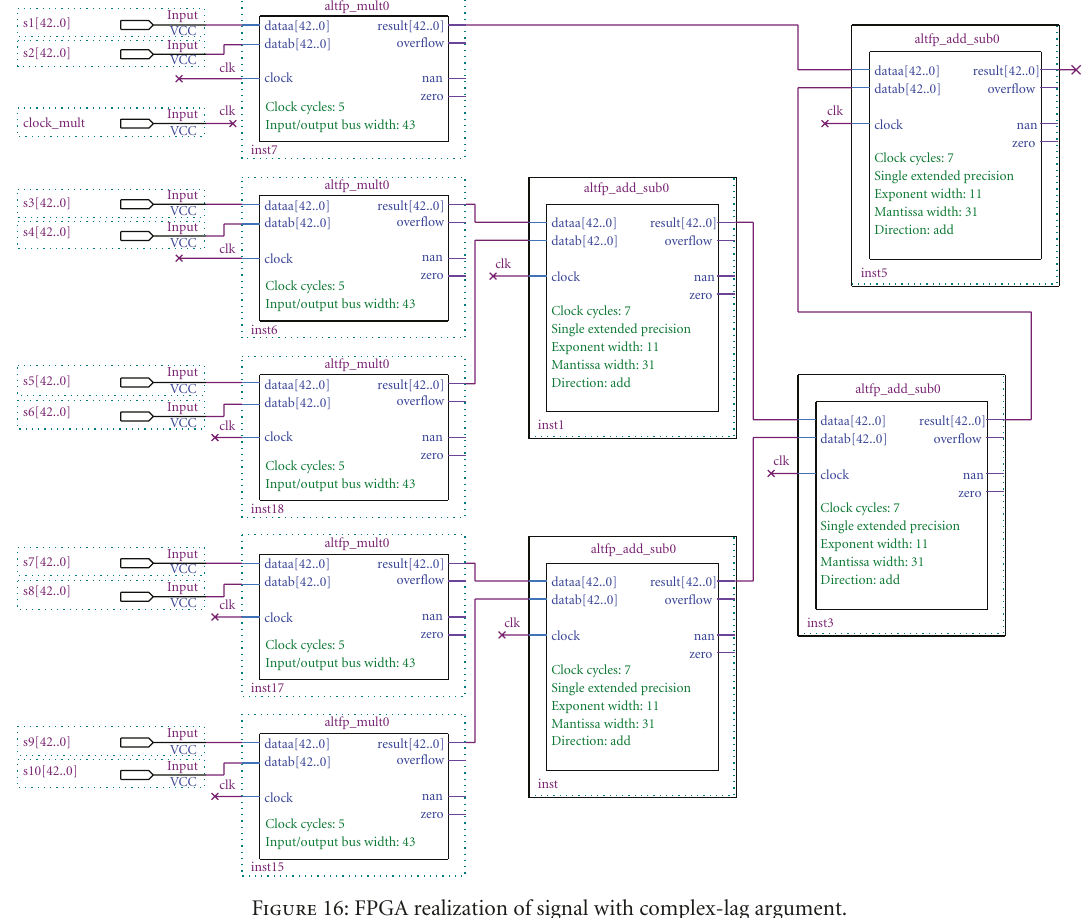
Figure 16: FPGA realization of signal with complex-lag argument.